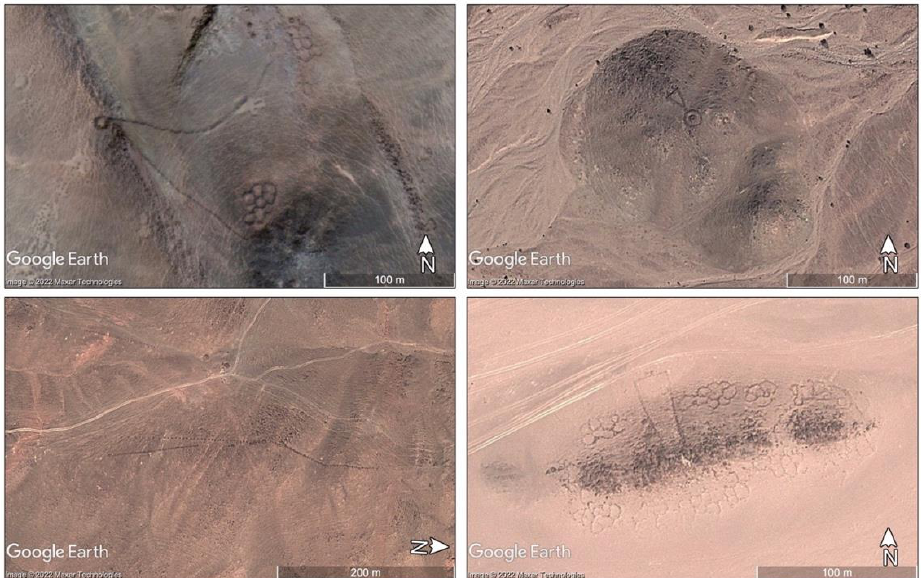
Figure 4. Satellite images of principal site types recorded (clockwise from top left: A V-shaped kite and clusters of enclosures; A ringed tomb and adjacent triangle structure; A possible mustatil structure and clusters of enclosures; A group of pendant structures. Source: Google Earth.